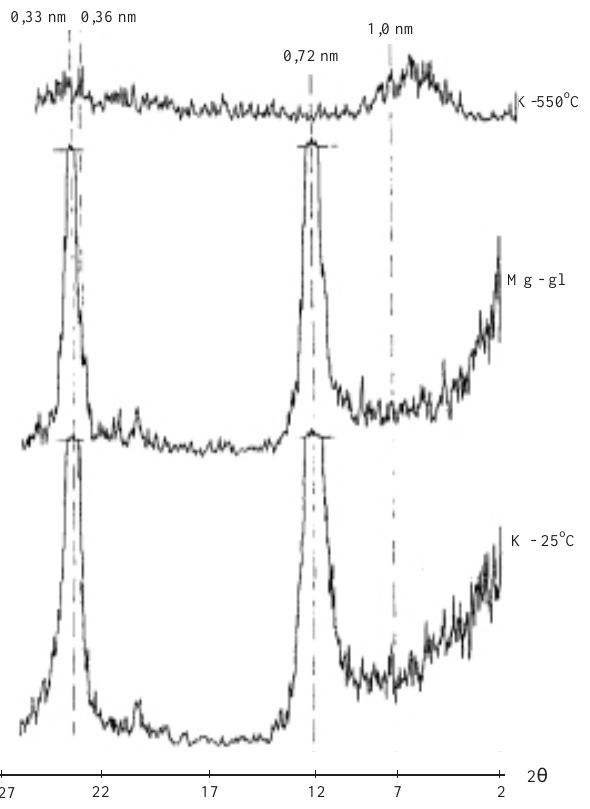
Figura 5. Mineralogia da fração argila do horizonte do Podzólico Vermelho-Amarelo. M = Mica; B t Ka = Caulinita.